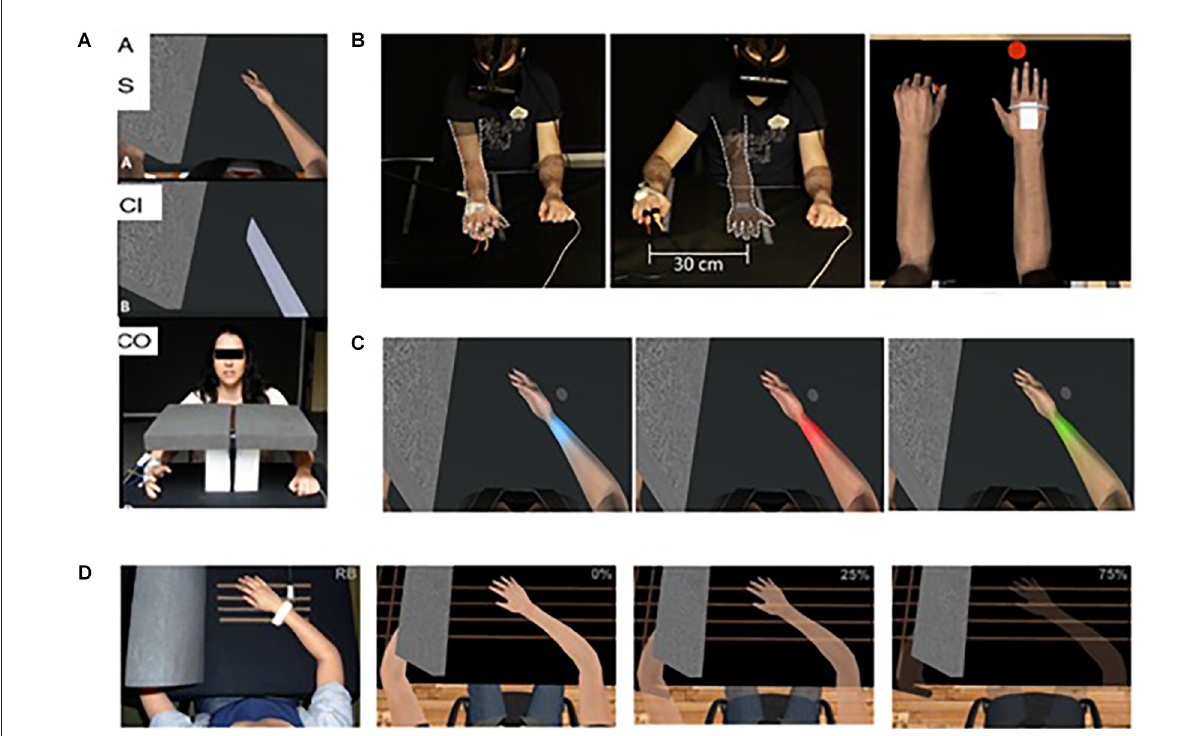
FIGURE1 Virtual embodiment experimental setups. (A) Martini et al. (2014) showed that the embodiment of a co-located virtual arm is analgesic compared to a non-VR control (in which the arm is hidden; bottom) and a within-VR condition (where a non-corporeal object replaced the virtual arm; middle). Taken from Martini, M., Perez-Marcos, D., and Sanchez-Vives, M. V. (2014). Modulation of pain threshold by virtual body ownership. Eur. J. Pain 18, 1040–1048. doi: 10.1002/j.1532-2149.2014.00451.x, © Wiley, used with permission. (B) Nierula et al. (2017) showed that the analgesic effect of virtual embodiment relies on co-location of the real and virtual limbs of no more than 30 cm difference. Reprinted from Nierula, B. et al. (2017). Seeing an embodied virtual hand is analgesic contingent on colocation. The Journal of Pain 18, 645–655. doi: 10.1016/j.jpain.2017.01.003, © 2017 with permission from Elsevier. (C,D) Martini et al. (2013, 2015) showed that manipulation of the appearance of the embodied virtual body can cause an alteration of pain threshold in healthy populations. Used with permission.